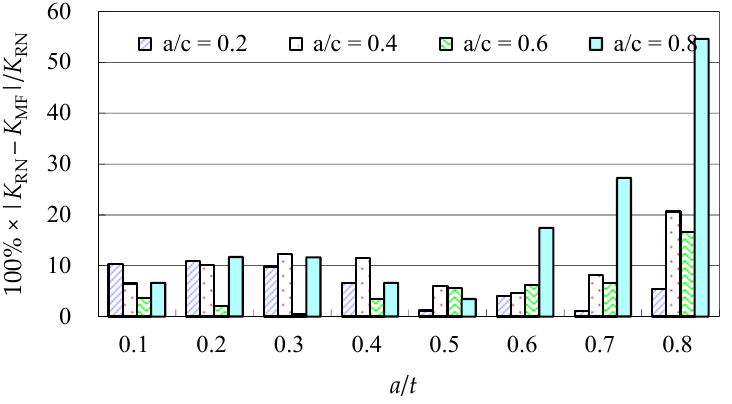
Figure 14. Modified formula vs. the Raju-Newman solution at point A ( c / W = 0.1).